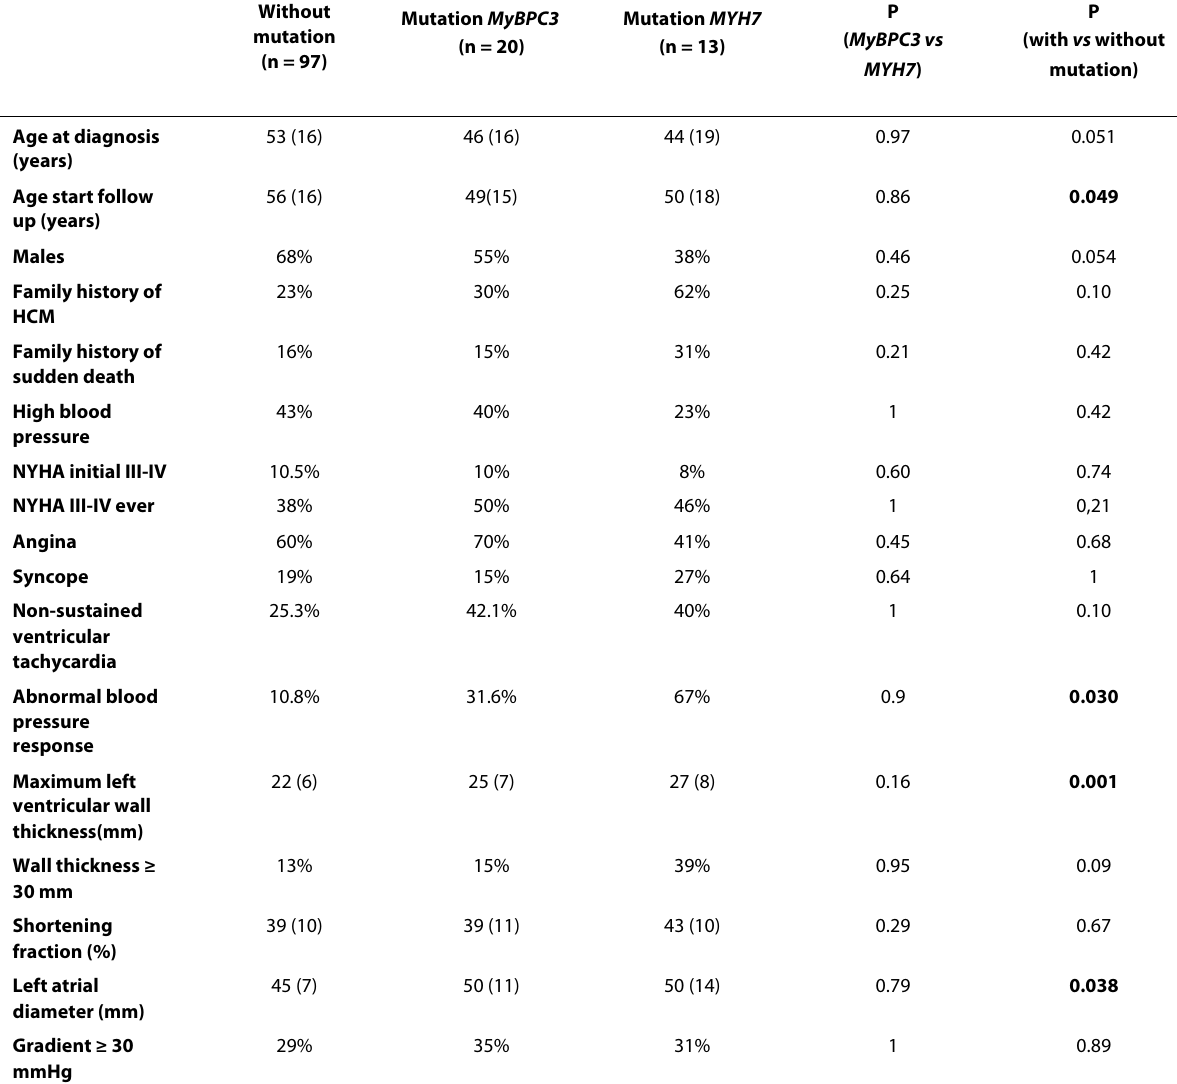
Table 2: Phenotypic characteristics of the index